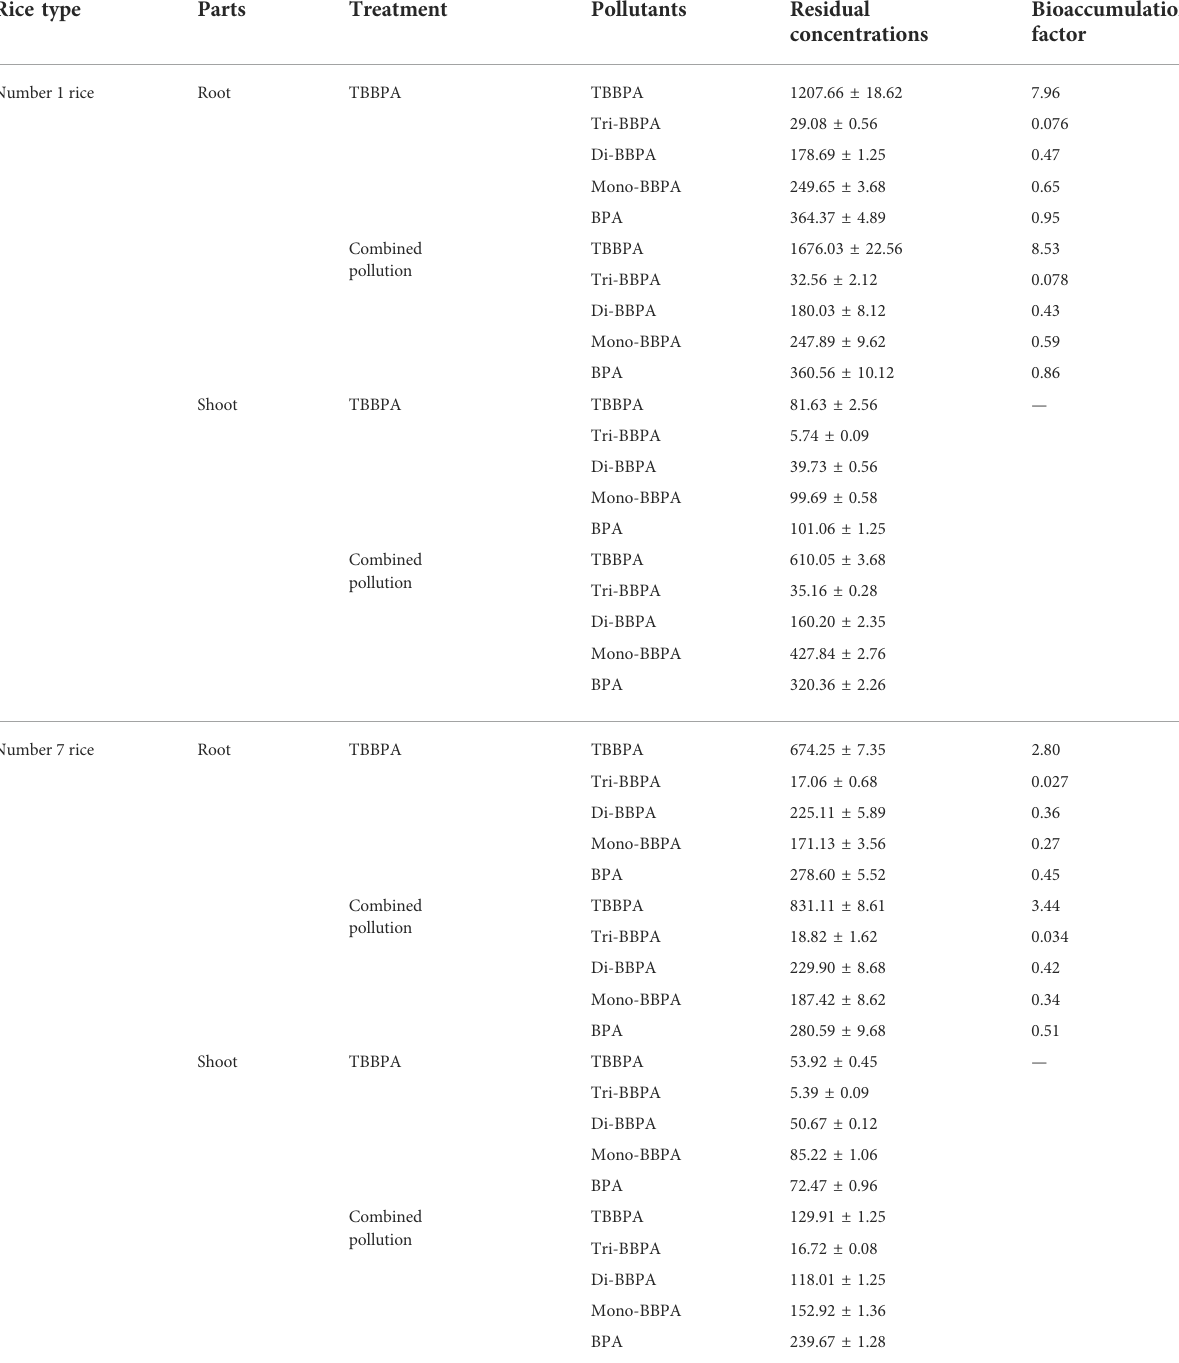
TABLE 3 Residual concentrations and bioaccumulation factor of TBBPA and its metabolites in rice